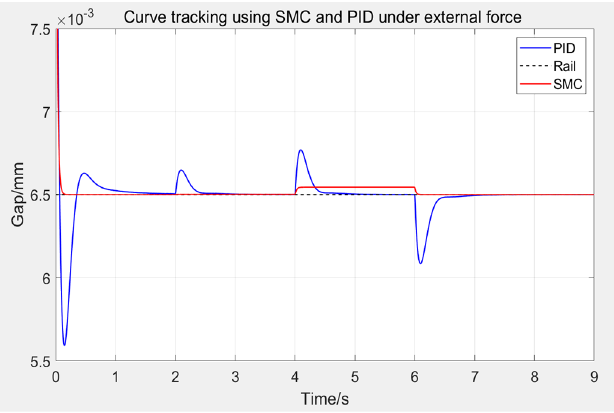
Figure 12. Curve tracking using SMC and PID under external force.